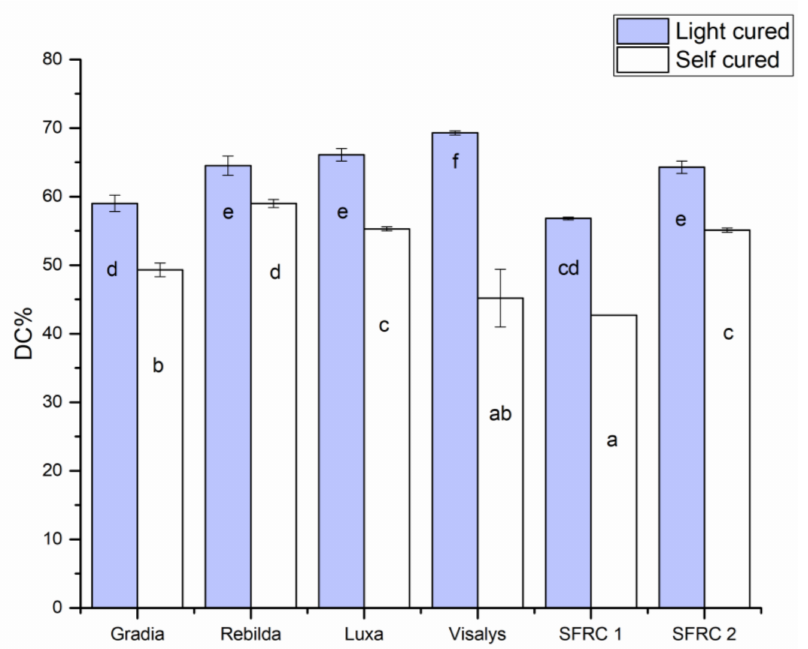
Figure 3. Bar graph illustrating the means of degree of conversion percentage (DC%) calculated at the bottom surface of tested DC resin composites. Groups denoted with the same letters are not statistically different ( p <